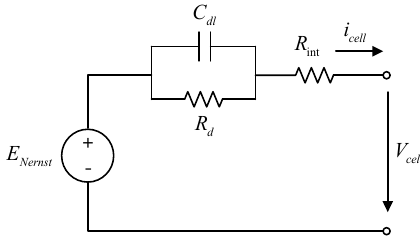
Figure 8. A simplified model of the fuel cell.